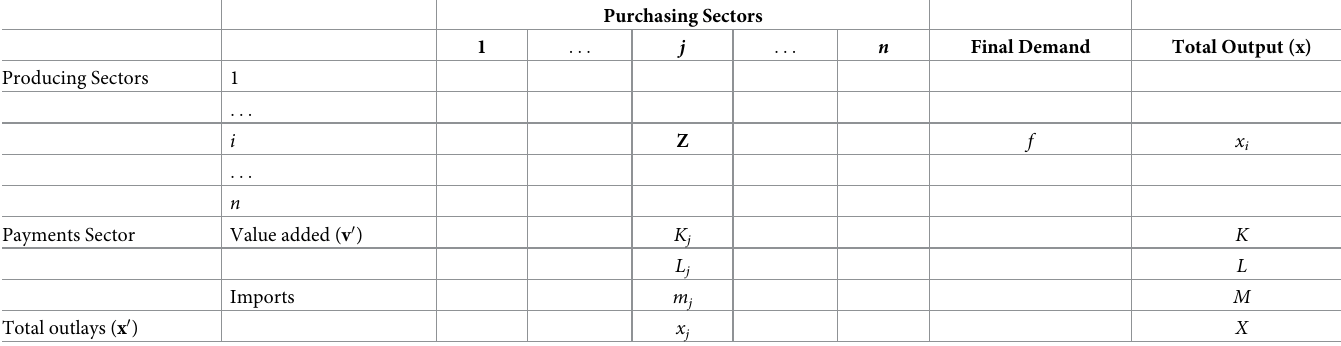
Table 4. Schematic Input-Output table with Z denoting the intermediate flow matrix, the final demand f , the capital stock K , labour L and imports m . Purchasing